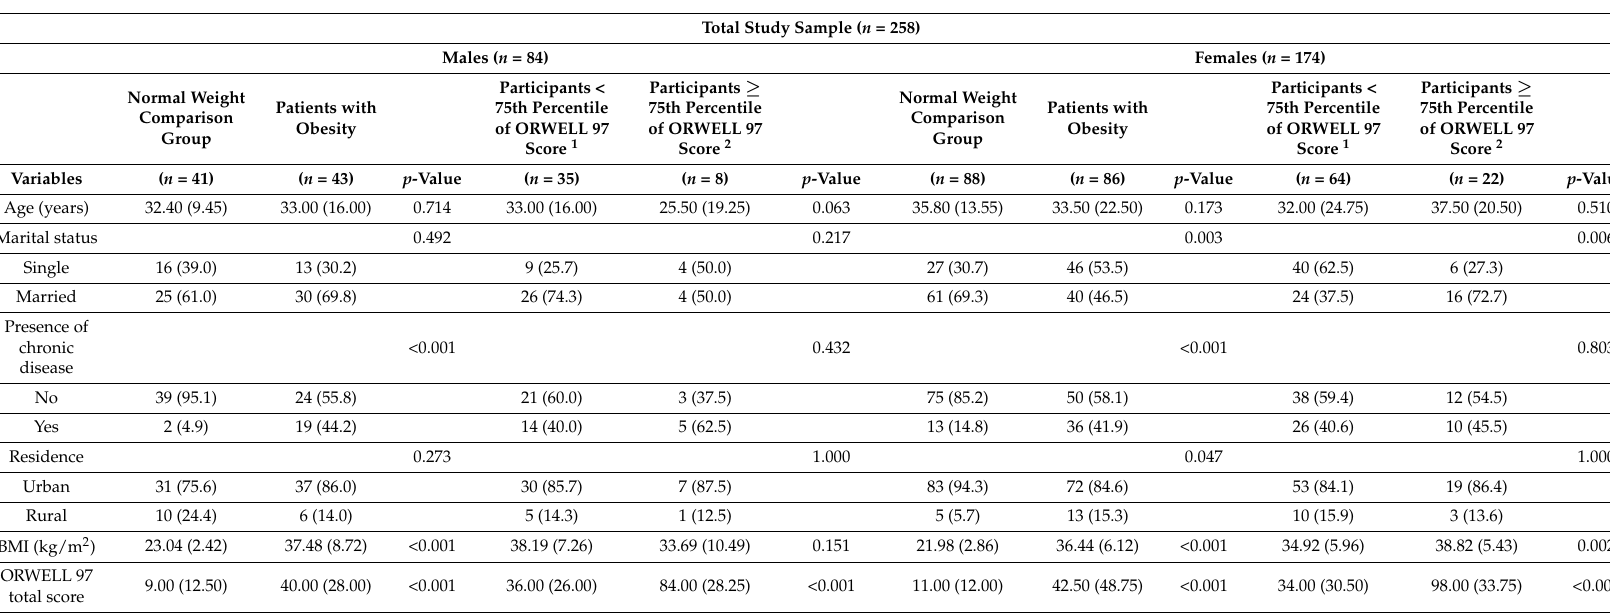
Table 1. Sociodemographic characteristics, body mass index (BMI) and global ORWELL 97 scores in the study population split by males and females ( n =